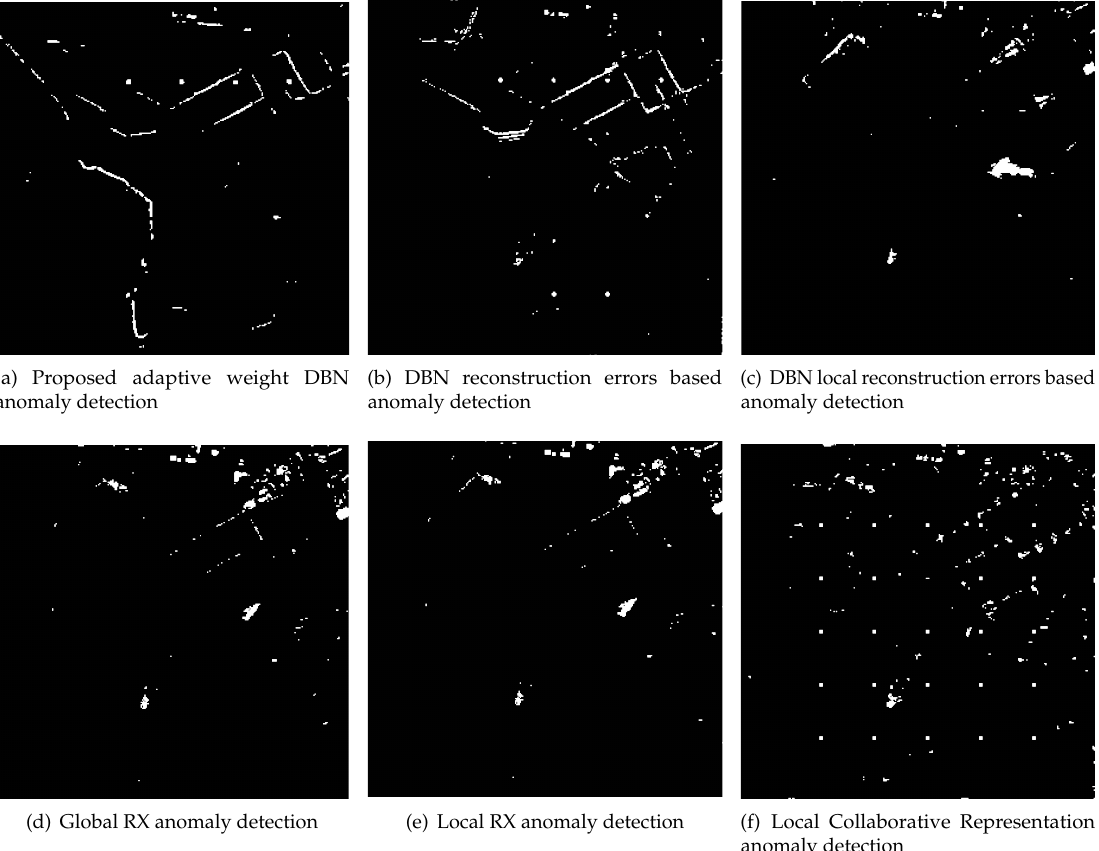
Figure 13. The targets detection result image of San Jose HSI image. Fixed positive alarm rate for all images in Figure 13 is